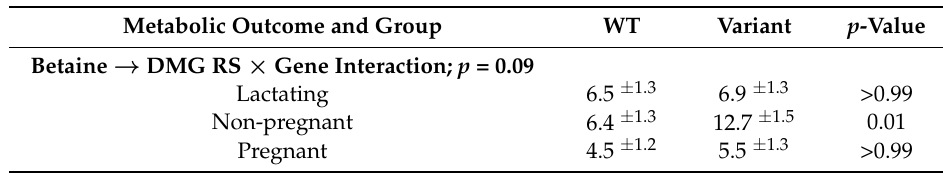
Table 8. Comparison of choline → CDP-PC turnover between CHDH rs12676 genotype by reproductive state. Values are least-squared means ± standard errors in ratios.